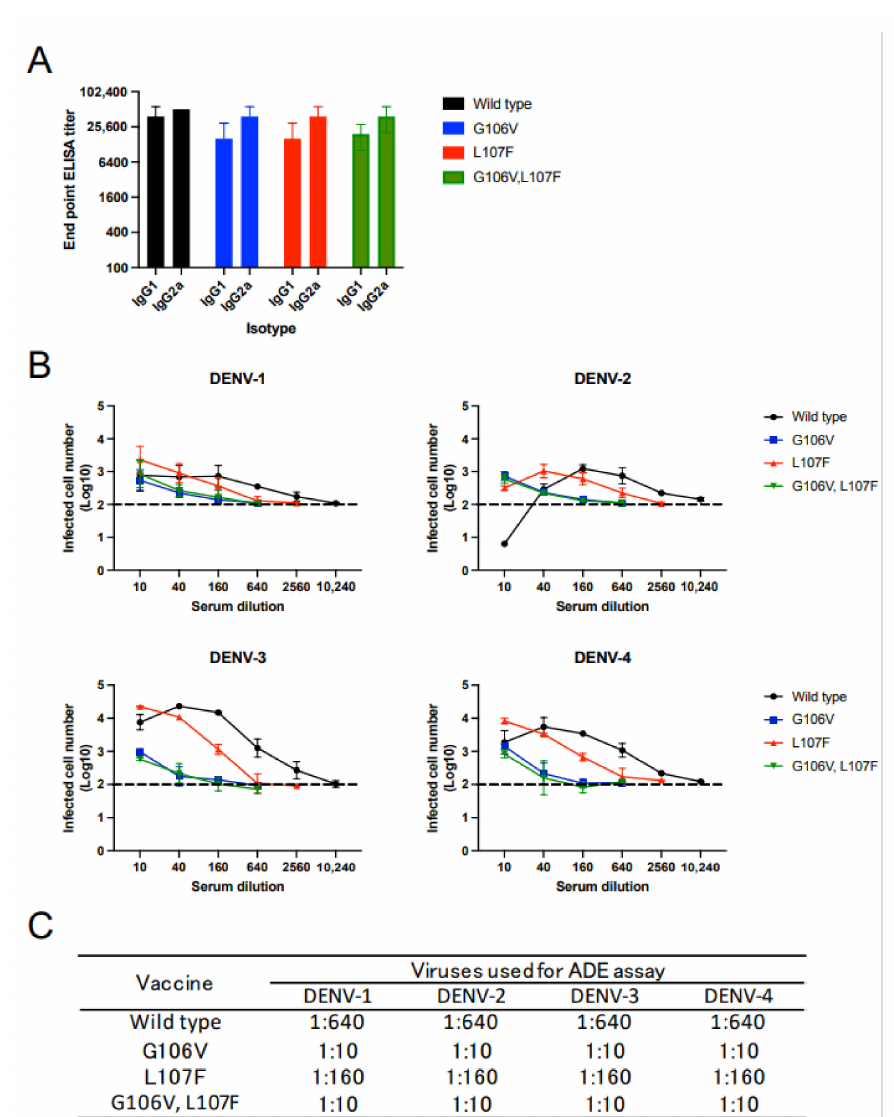
Figure 4. Analysis of Th1/Th2 balance induced by the vaccines. ( A ) IgG1 and IgG2a levels induced by JE DNA vaccines. JEV was coated onto the ELISA plate. Serially diluted serum was used as the detector antibody. Additionally, AP-conjugated antibodies against IgG1 or IgG2a were added for color development. The endpoint titer is expressed as the maximum dilution yielding a two-times higher value than the negative-control average. ( B ) ADE activity in the presence of complement. Dotted lines indicate the baseline of the control-infected cells (100 infected cells; log 10 2.0). Complement